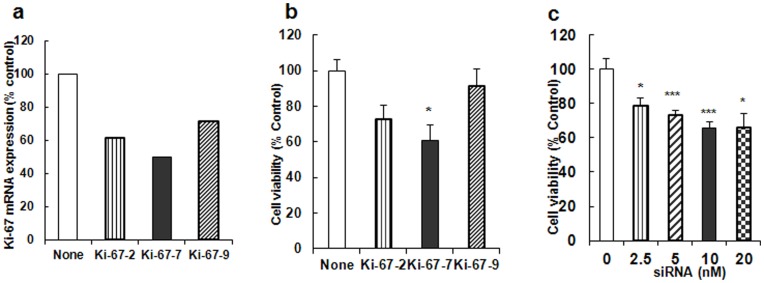
Effect of various DsiRNA constructs on a) Ki-67 mRNA expression and b) cell proliferation in bladder cancer cells; c) Dose-response studies with Ki-67-7. a) Rat TCC cells (AY-27) were cultured in 12-well plates (∼0.8×105 cells/well) as described in Materials and Methods. After 24 h, they were transfected with each of the siRNA constructs (Ki-67-2, Ki-67-7 and Ki-67-9) targeted against Ki-67 mRNA. After 48 h, RNA was extracted and the levels of mRNA were determined by quantitative PCR as described in Methods. Cells treated with the transfection reagent alone were used as the control. The rate of expression of Ki-67 mRNA was normalized to the expression of β-actin. Values represent data from one (of two) experiment using the average of triplicate determinations. b) AY-27 cells were cultured in 12-well (0.8×105 cells/well) plates for 24 h and transfected with various siRNA constructs as described in Methods. Cell viability was determined 48 h after transfection by MTT assay. Cells treated with transfection reagent alone served as the control ( = 100%). Bars indicate values which are the means ± S.E of three determinations. (*P<0.05). c) AY-27 cells were cultured in 12-well plates (0.8×105 cells/well) as described in Methods. Forty eight hours after siRNA transfection, the effect of various concentrations of Ki-67-7 on cell viability was determined by MTT assay. Cells treated with transfection reagent alone served as the control. Cell viability values are expressed as percent control and are the means ± S.E of 3-8 determinations (*P<0.05, ***P<0.005).